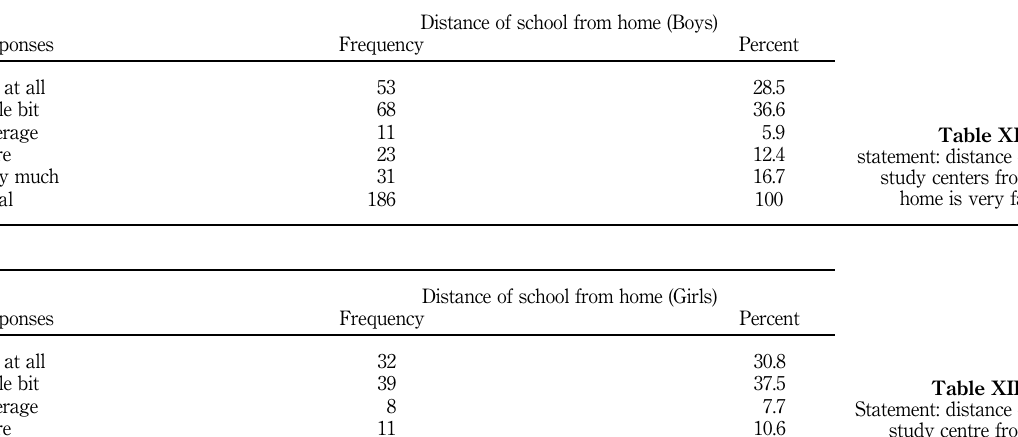
Table XIII. Statement: distance